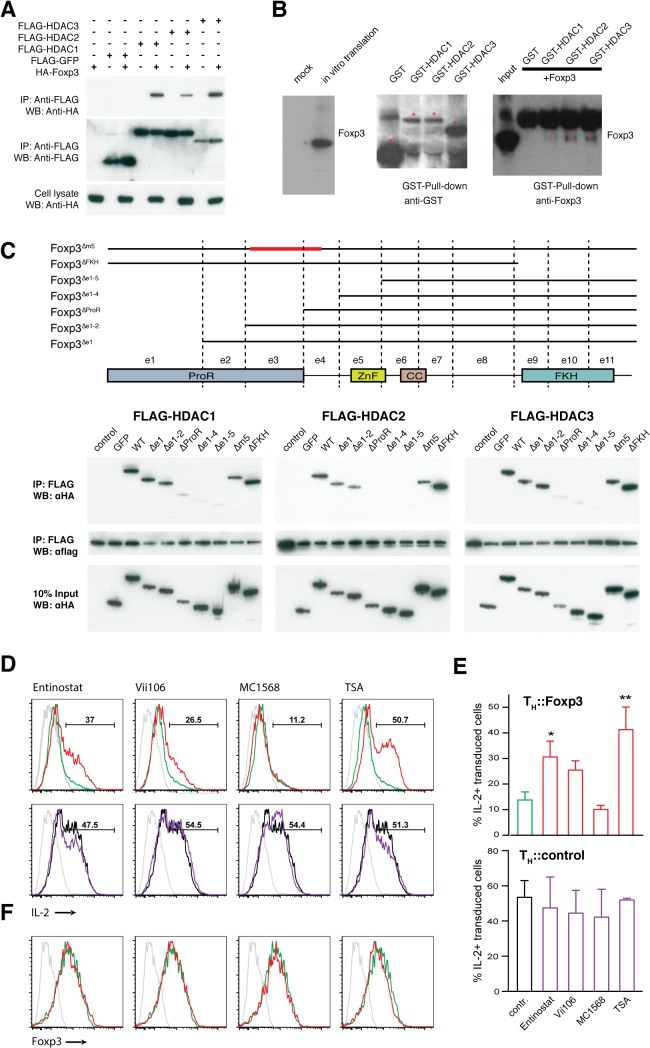
Foxp3 interacts physically with class I HDACs to suppress IL-2.(A) Foxp3 associates with Class I HDACs within cells. HEK293T cells were co-transfected with vectors expressing FLAG-HDAC1, 2, 3 or FLAG-GFP and HA-Foxp3. Cell lysates were immunoprecipitated with anti-FLAG M2 agarose, followed by Western blotting with anti-HA (top), or anti-FLAG (middle) antibodies. The expression of Foxp3 in cell lysate was detected with anti-HA (bottom). (B) Foxp3 directly interacts with Class I HDACs. In vitro translated Foxp3 (left) was incubated with bacterially expressed GST-HDAC1, 2, 3 or GST alone. After pull down with GST-affinity beads, the eluent was analyzed by immunoblotting with anti-GST (middle) and anti-Foxp3 (right). Asterisk indicates corresponding GST-fused protein. (C) Interaction of Foxp3 with class I HDACs. (top) Schematic illustration of Foxp3 and the various deletion constructs. ProR: proline-rich domain; ZnF: zinc finger domain; CC: coiled-coil domain; FKH: forkhead domain. Immunoprecipitation of (bottom left) FLAG-HDAC1, (bottom middle) FLAG-HDAC2 and (bottom right) FLAG-HDAC3 co-transfected into 293T cells with HA-tagged Foxp3 or the respective Foxp3 mutants. The lysates were immunoprecipitated with anti-FLAG M2 agarose. Precipitated proteins were probed with anti-HA or anti-FLAG antibodies. (D) Intracellular IL-2 level in (top) TH::Foxp3 cells and (bottom) TH::control cells in the absence (green, black) or presence (red, purple) of the respective inhibitor (isotype control in grey). Primary TH cells transduced, rested for 40 h and incubated 8 h with Class I HDAC inhibitor Entinostat (1.8 μM), Vii106 (2.4 μM), Class IIa HDAC inhibitor MC1568 (1.5 μM) or pan-HDAC inhibitor TSA (0.05 μM) respectively. The cells were re-activated in the presence of the corresponding HDAC inhibitor for 12 h. Data are representative of three independent experiments. (E) Mean percentage (± SD, n = 3) of cells producing IL-2 in total transduced rCD8a+ cells under the various conditions shown in (D). P values between control and treatment group were determined by ANOVA followed by Tukey’s post-hoc test (* indicates P<0.05; ** indicates P<0.01). (F) Intracellular Foxp3 expression level after HDAC inhibitor treatment. TH::Foxp3 in the absence (green) or presence (red) of the respective inhibitor (isotype control in grey). For (A), (C), (D) and (F) are representative results of three independent experiments. Blots in (B) are representative of two independent experiments.